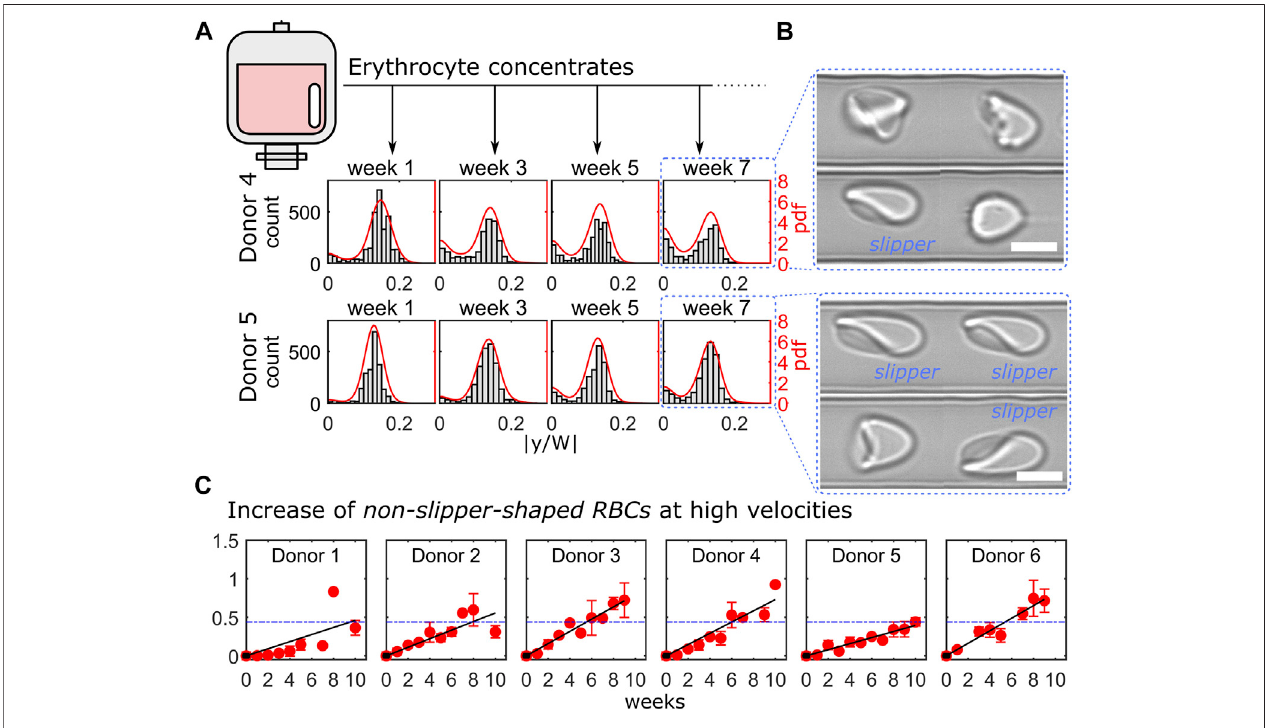
FIGURE4| Cellshapecharacterization within10weeksoferythrocyte concentratestorage. (A) Representativehistogramsand probabilitydensity functions(pdfs) of the RBC y-positions for donor 4 (top) and donor 5 (bottom) at a velocity of 10 mm/s for four consecutive weeks. (B) Representative RBC shapes for both donors at week 7. Scale bars represent 5 µm. (C) Ratio between centered cell shapes and slipper-shaped RBCs for all donors as a function of time. Red symbols correspond to measurements ’ averageoveravelocityrangeof8 – 10 mm/sandblacklinesrepresentlinear fi ts.Bluedashedhorizontallinesindicatethemeanvalueofthelinear fi ts for all donors at week 6. The analysis presented was performed on in average 4847 cells per donor and time point (between 2213 and 9958 cells).